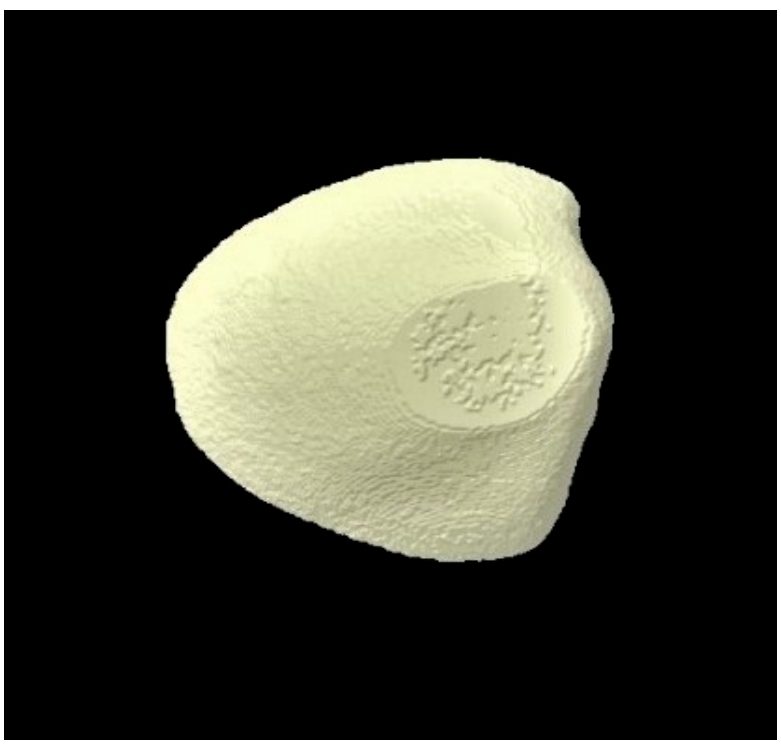
Figure 6. Micro-CT image of group 2 samples presenting enamel surface post-demineralization.